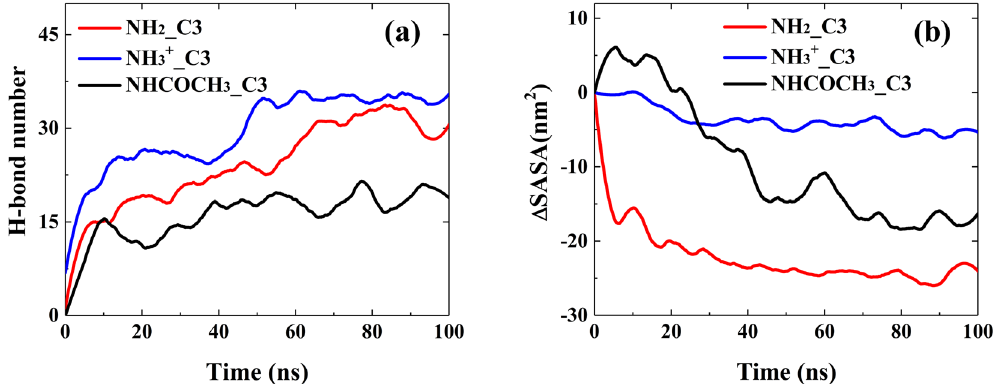
Figure 4. ( a ) The number of inter-molecular H-bonds between different functional groups and C3. ( b ) The SASA change of different types of chitosan in chitosan/C3 systems versus the simulation time.